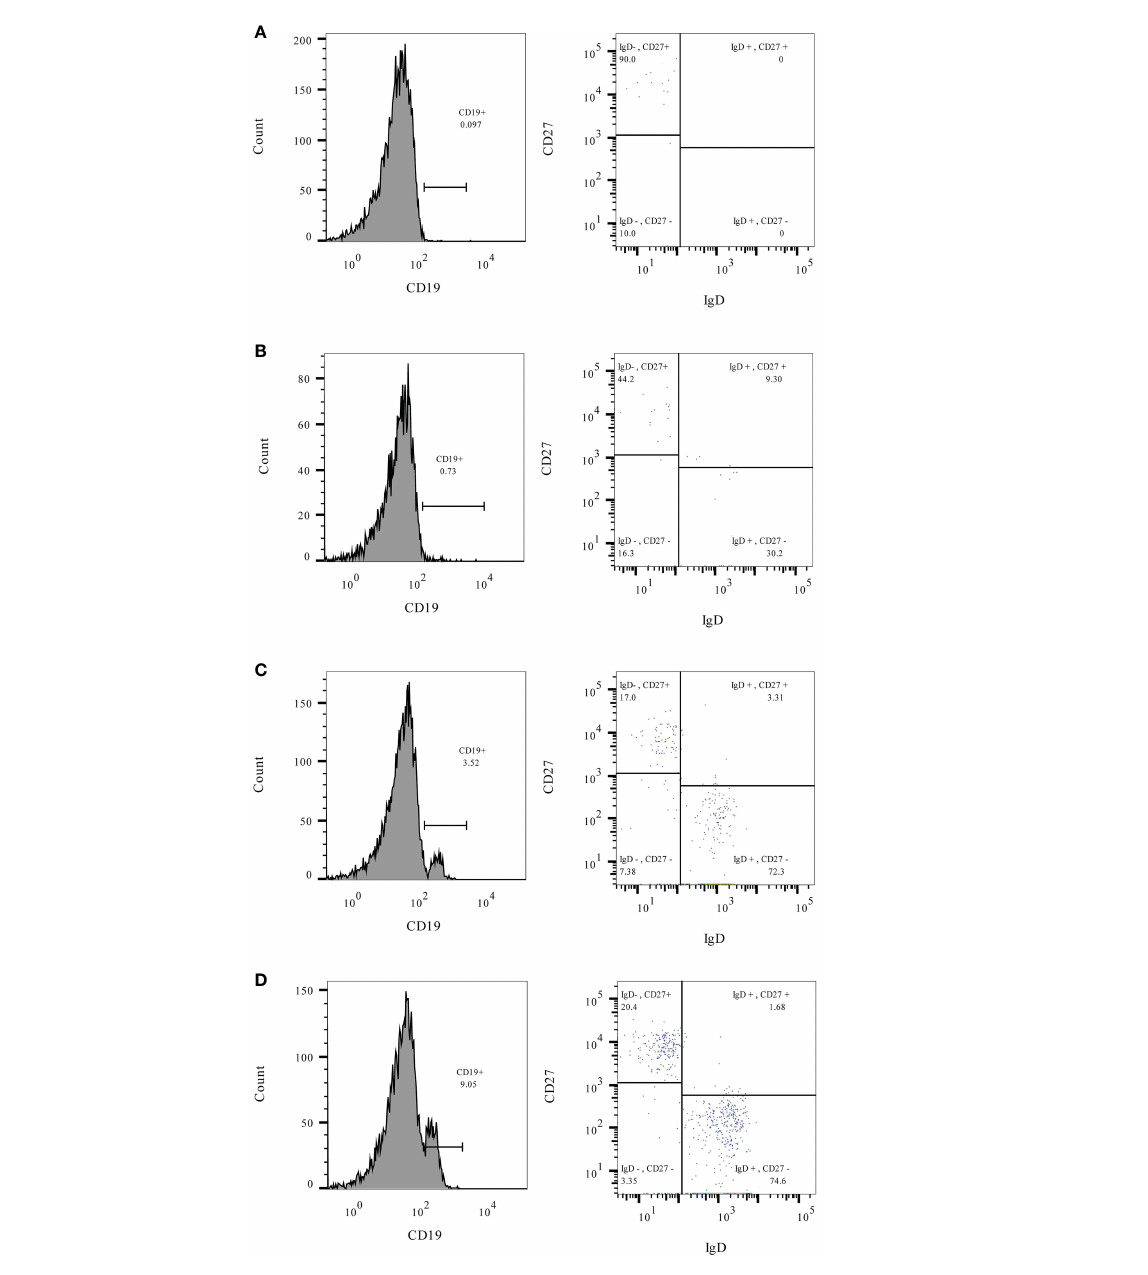
FIGURE 2 The percentages of total (CD19+), naïve (CD19+/IgD+/CD27-), and memory (CD19+/IgD-/CD27+) B lymphocytes measured before COVID-19 vaccination in rituximab-exposed subjects with different rituximab-to-vaccination intervals. Examples of pre-vaccination B lymphocyte immunophenotyping † were demonstrated for rituximab-exposed subjects with rituximab-to-vaccination intervals of 3-6 months (A) , 6-9 months (B) , 9-12 months (C) , and more than 12 months (D) . Naïve B lymphocytes predominated the B lymphocyte population of subjects with rituximab-to- vaccination intervals longer than nine months. † Leukocytes were prepared for fl ow cytometry from 25µL of fresh heparinized blood using Lyse/Stain/ Wash method. Fluorescent-conjugated antibodies used for staining include C45-PE (Cat. No. 368510 Biolegend, SD, CA), CD19-PerCP-Cy5.5 (Cat. No. 45-0199-42, Thermo Fisher Scienti fi c, WLM, MA), IgD-FITC (Cat. No. 11-9868-42, Thermo Fisher Scienti fi c, WLM, MA), and CD27-PE-Cy7 (Cat. No. 25-0271-82, Thermo Fisher Scienti fi c, WLM, MA). Lymphocytes were identi fi ed by size (forward scatter) and granularity (side scatter) and con fi rmed with surface expression of CD19 and CD45. CD19+ B lymphocytes were gated as naïve or memory subsets based on their IgD and CD27 expression